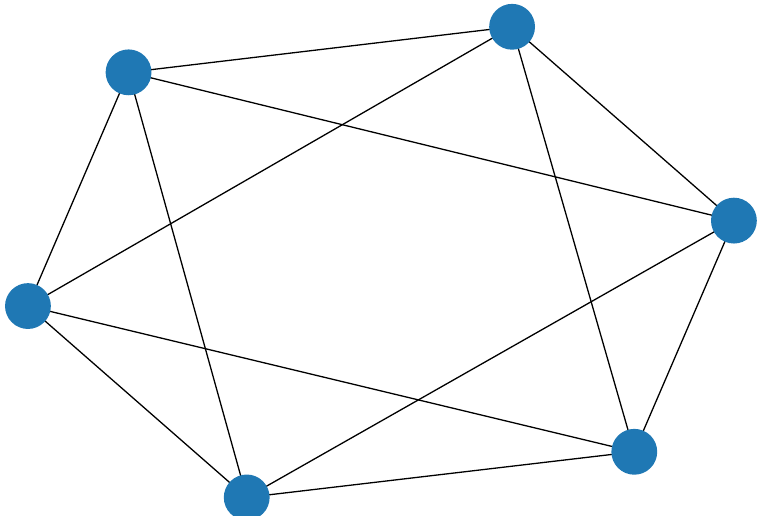
Fig 2. Source graph of the break minimization problem defined by Table 1. The blue nodes represent logical variables, and the solid black lines represent the interaction between variables.